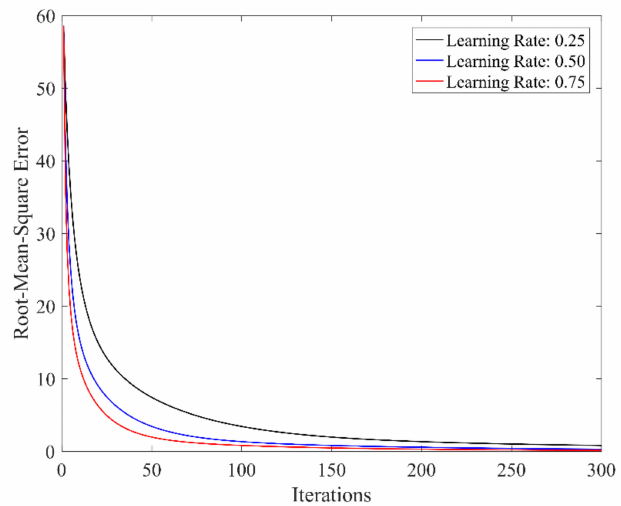
Figure 8. Relationship between error cost and learning times under di ff erent learning rates (n =